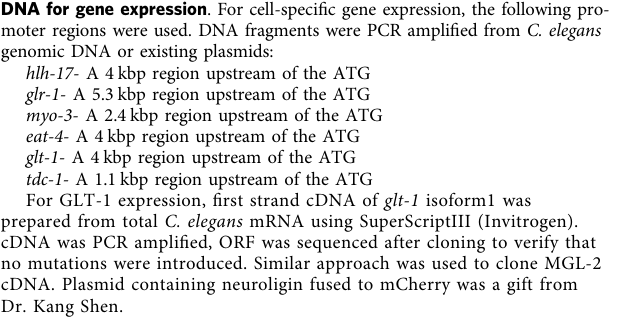
DNA for gene expression . For cell-speci fi c gene expression, the following pro- moter regions were used. DNA fragments were PCR ampli fi ed from C.